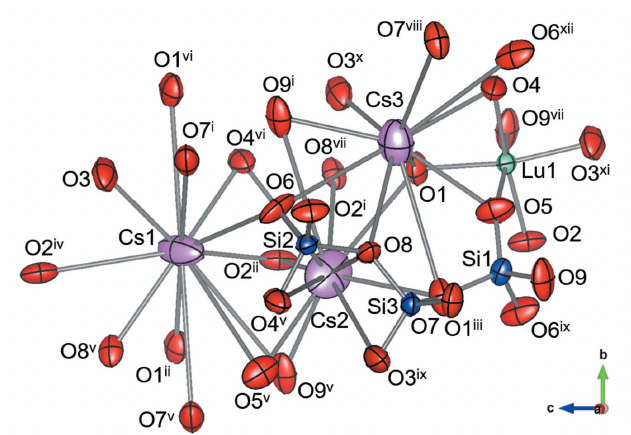
Figure 1 Atomic arrangement of Cs 3 LuSi 3 O 9 shown with displacement